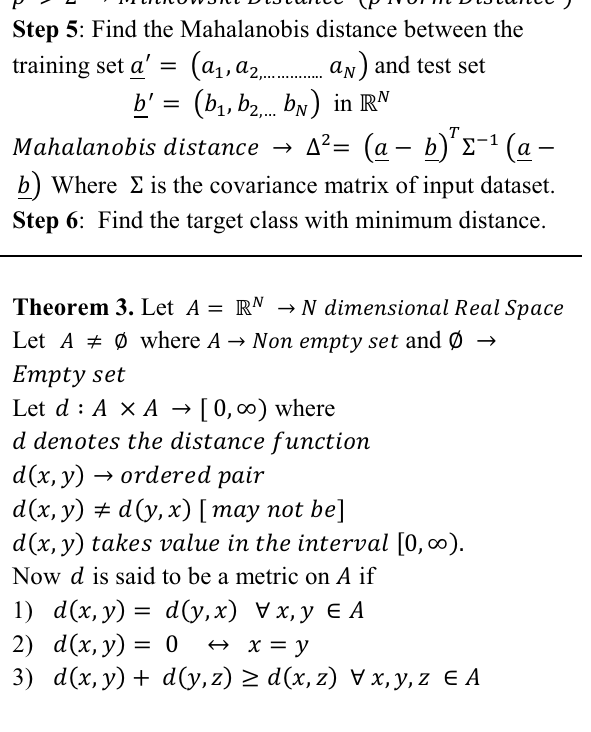
Algorithm 4: Polynomial based distance